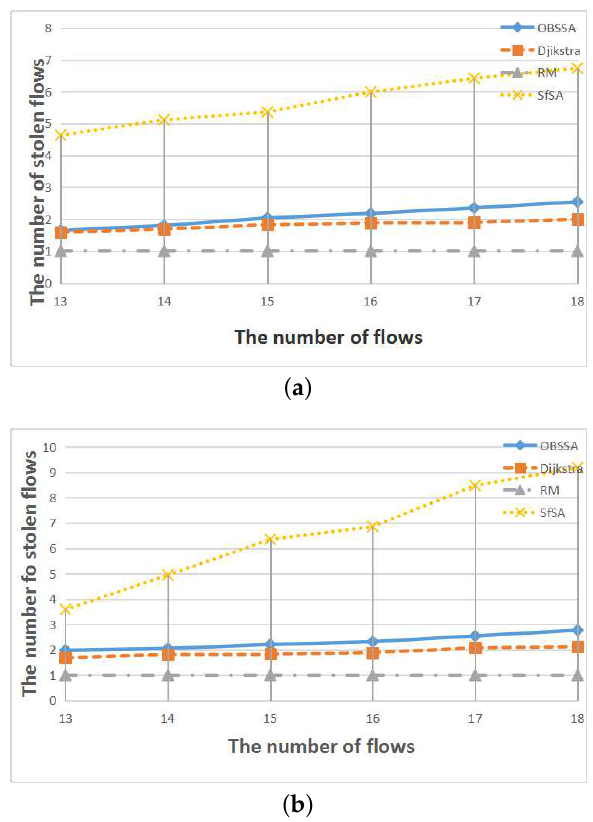
Figure 12. The relationships between the number of stolen flows and the number of nodes. ( a ) N = 50, U = 0.4; ( b ) N = 50, U = 0.5.